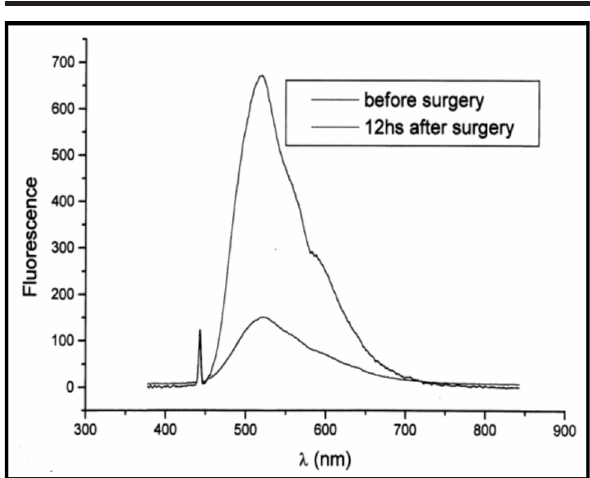
FIGURE 7 - Compare the fluorescence spectrum from a single animal excited at 442 nm, before and 12h after partial hepatectomy.